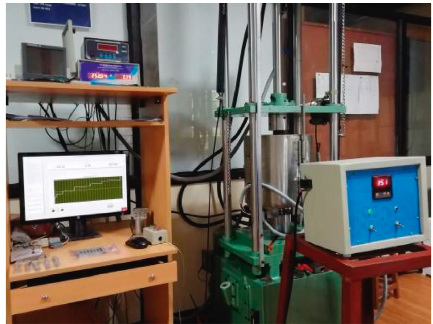
Figure 3: Universal tensile testing machine attached with heating chamber and temperature controller (Model: CUTM-50